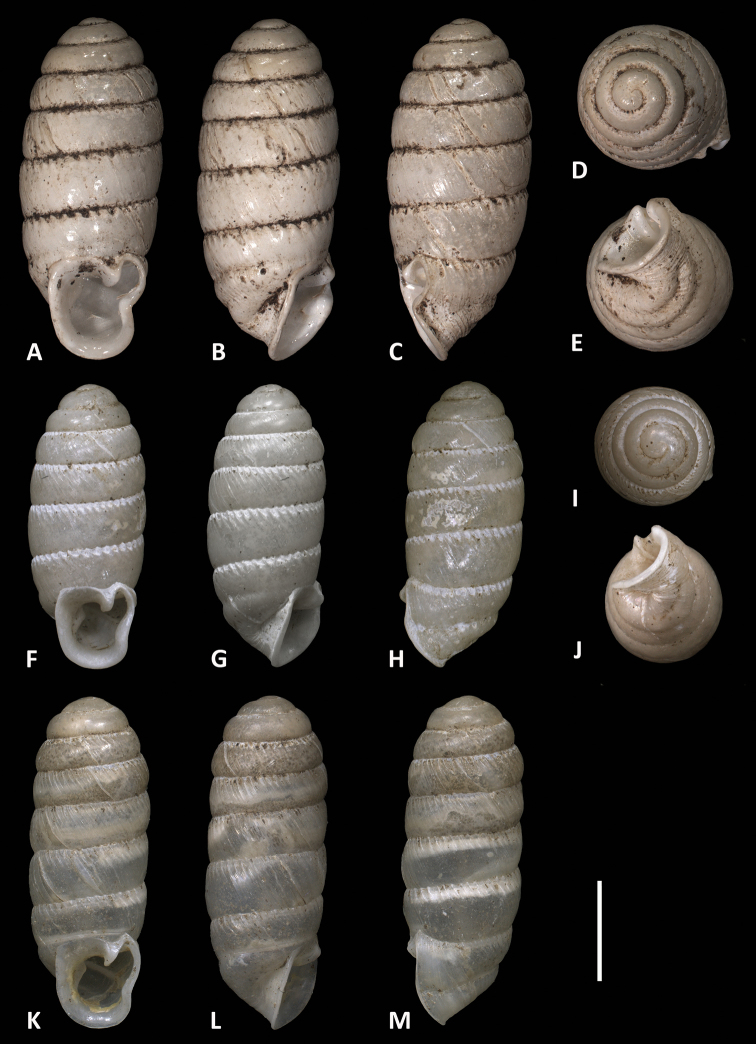
Different views of voucher specimens of Enneaserrata d’Ailly, 1896 from Musake Haus, Mount Cameroon (A–EZMB 101777) and E.nigeriensis sp. n. (F–J and K–MRMNH.MOL.341195). Scale bar: 2 mm.